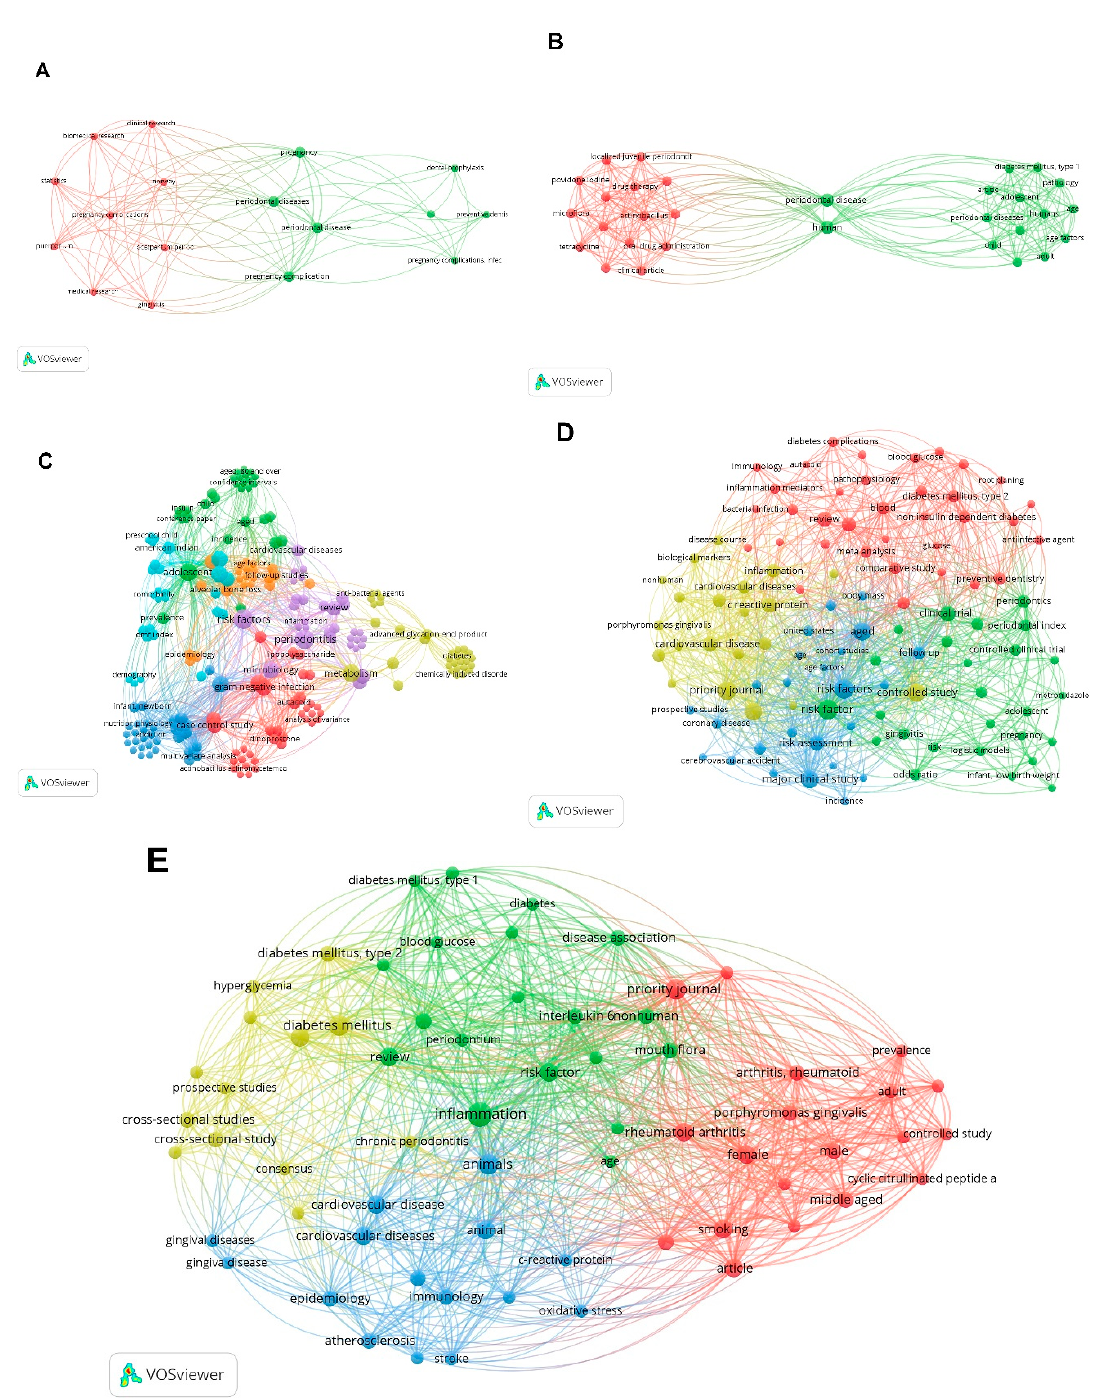
Figure 4. The distribution of the keywords over ( A ) 1960s, ( B ) 1980s, ( C ) 1990s, ( D ) 2000s, and ( E ) 2010s. The size of the node represents the frequency of the keyword